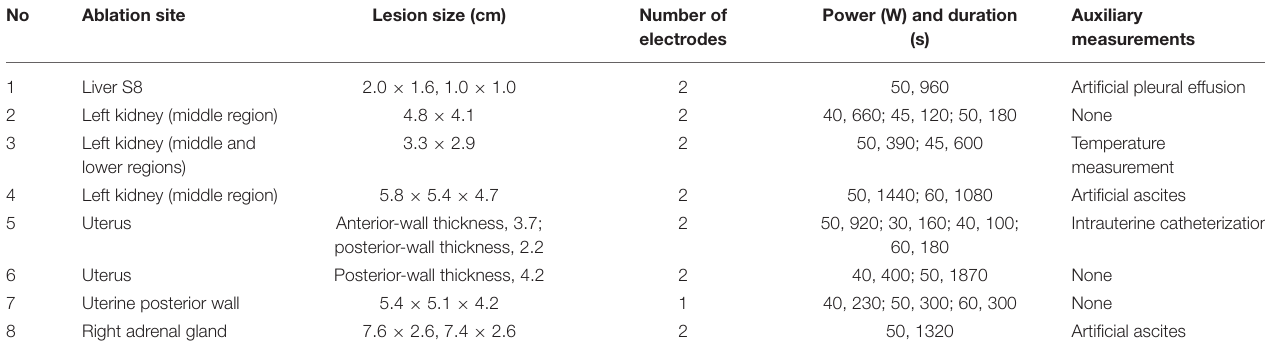
TABLE 2 | Auxiliary